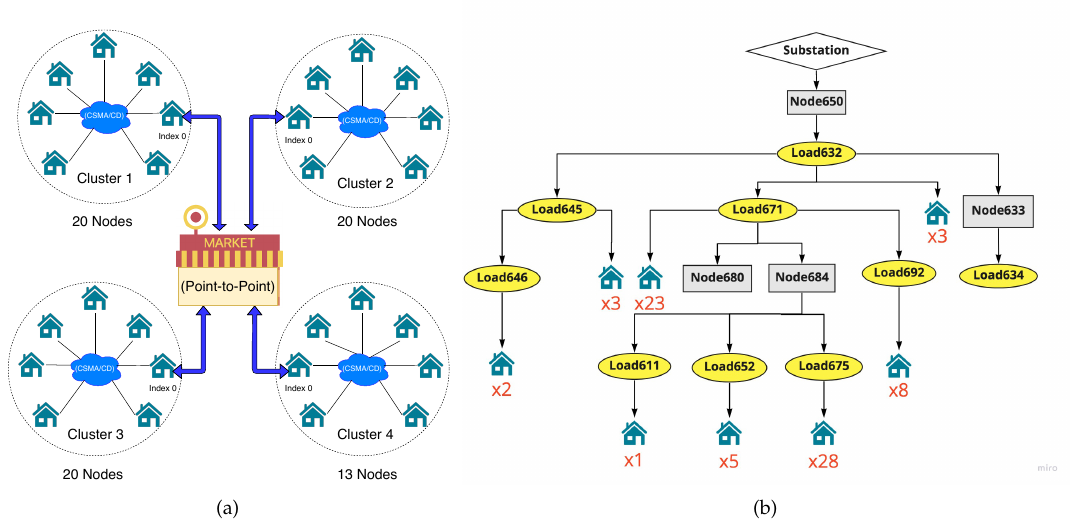
Figure 4. ( a ) The network model and ( b ) the power grid model of IEEE 13 node test feeder with 73